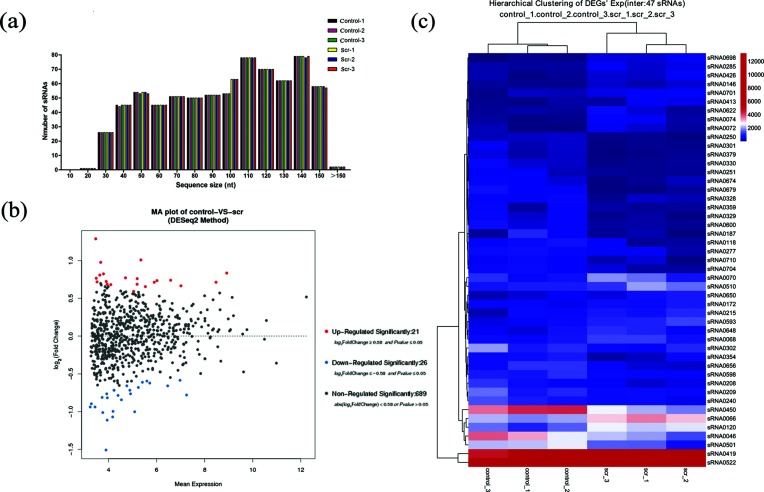
Overall distribution of the small RNA compositions of the generated libraries and differential expression analysis of candidate sRNAs. (a) Length distributions and abundances of small RNAs in the six samples. The sRNA lengths (nt) are shown on the x-axis and the numbers of sRNAs are presented on the y-axis.(b) An MA plot shows the distribution of fold changes in sRNA expression. Upregulated genes with a log2- fold change of ≥0.58 and P-value of ≤0.05 are indicated in red, and downregulated genes with a log2-fold change of ≤−0.58 and a P-value of ≤0.05 are indicated in blue. (c) Heat maps were produced from a hierarchical cluster analysis and showed 47 differentially expressed sRNAs. The colour scale on the right showsthe relative expression levels of the sRNAs across all the samples: red represents expression >3000 and blue represents expression <3000. (Control indicates the 0 % sucrose condition and scr indicates the 1 % sucrose condition.)